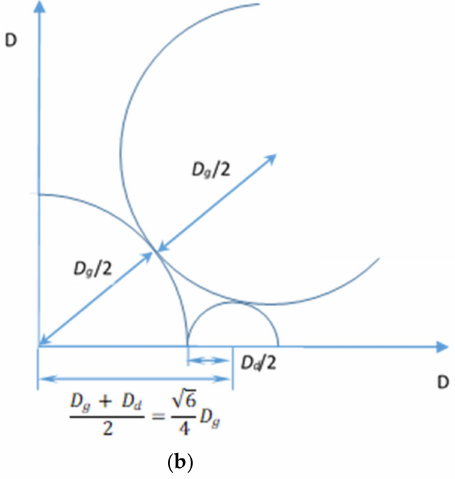
Figure 2. Model of the optimal concentration of spheres [22]: ( a ) the maximum packing of spheres, where volume occupied by isomorphic coarse spheres in relation to the total volume of the bed is = 0.7405. ( b ) 2D cross-section for the selected case of two fractions: coarse and fine grains ρ / ρ o elected from the series of spheres, D d =